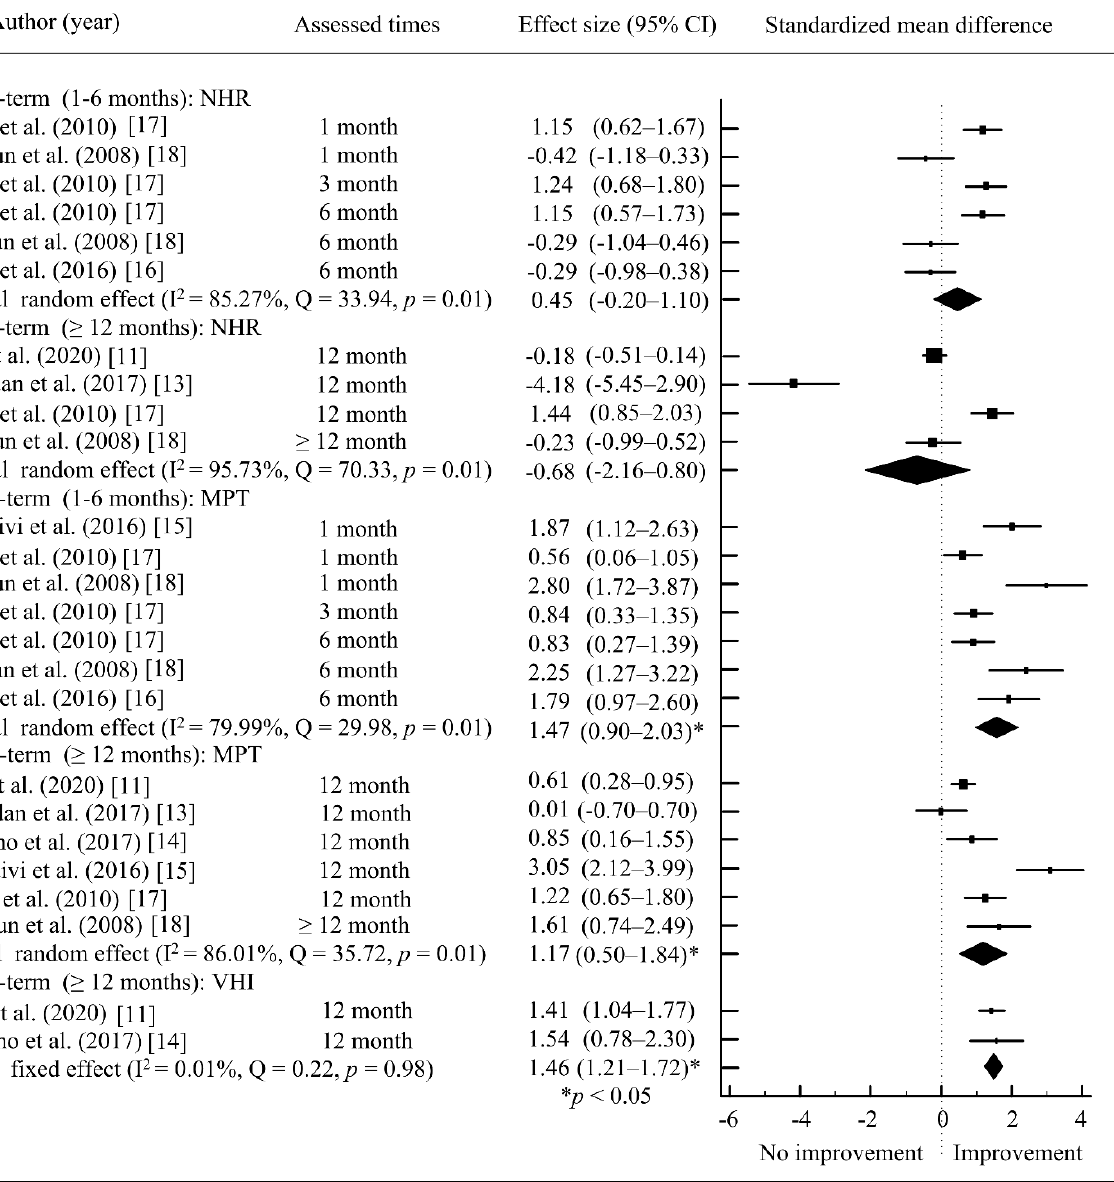
Figure 5. Meta-analysis of voice parameters (NHR and MPT) and quality of life after AFIL. * p < 0.05; ■, SMD; ◆ total SMD.